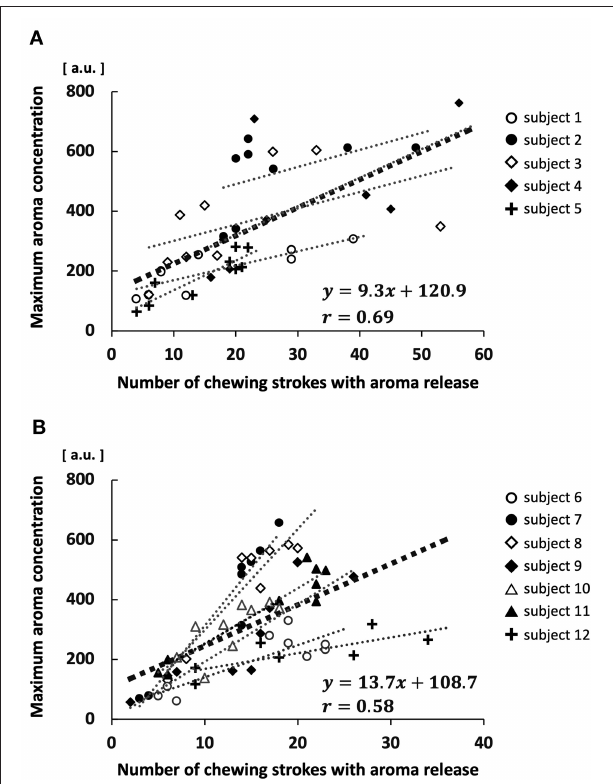
FIGURE 8 | Correlation between maximum aroma concentration and number of chewing strokes with aroma release in each participant. (A) High masticatory performance group. (B) Low masticatory performance group.